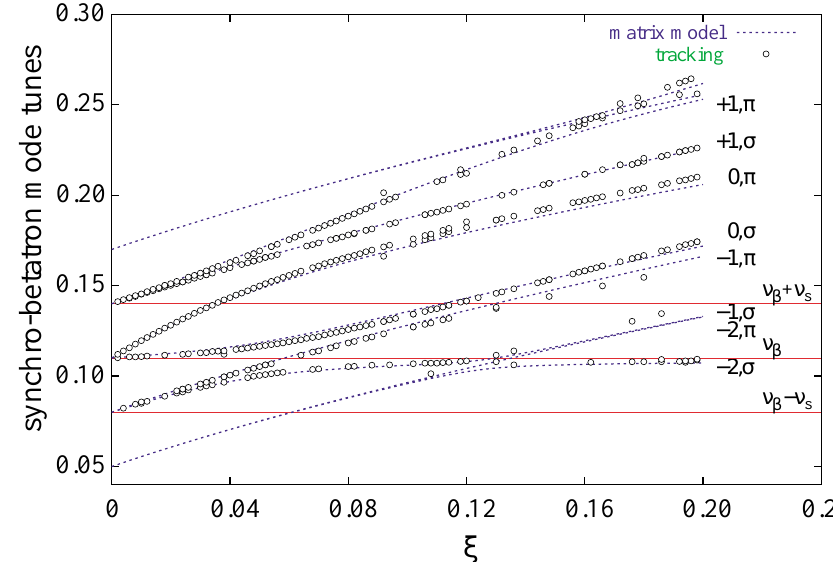
FIG. 3. (Color) Synchrobetatron mode tunes vs j . Comparison of the circulant matrix model and tracking. Equal bunch intensities, n b (cid:1) 0.11 , n s (cid:1) 0.03 , and the bunch length is 0.7 b (cid:1)